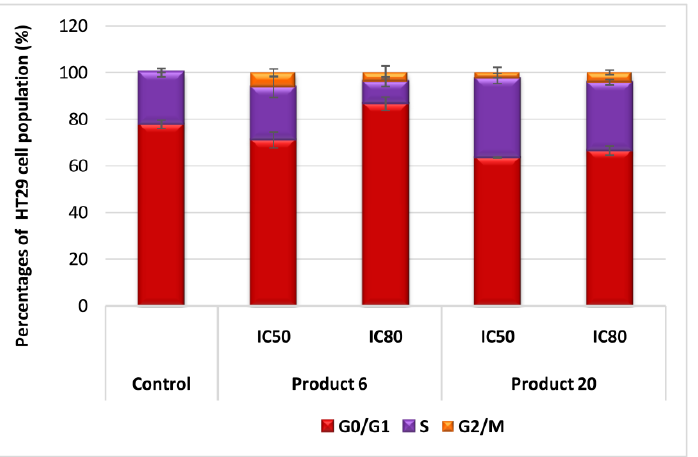
Figure 4. Changes in the cell percentage, in each phase of the cell cycle, of colon adenocarcinoma cells HT29, with respect to untreated control cells, after 72 h of exposure to compounds 6 and 20 , at IC 50 and IC 80 concentrations. The cell cycle was conducted after propidium iodide (PI) staining as described in the Experimental Section, G0/G1 phase (brown bars), S phase (purple bars), and G2/M phase (orange bars). Values represent means ± S.D. of at least three independent experiments performed in duplicate.